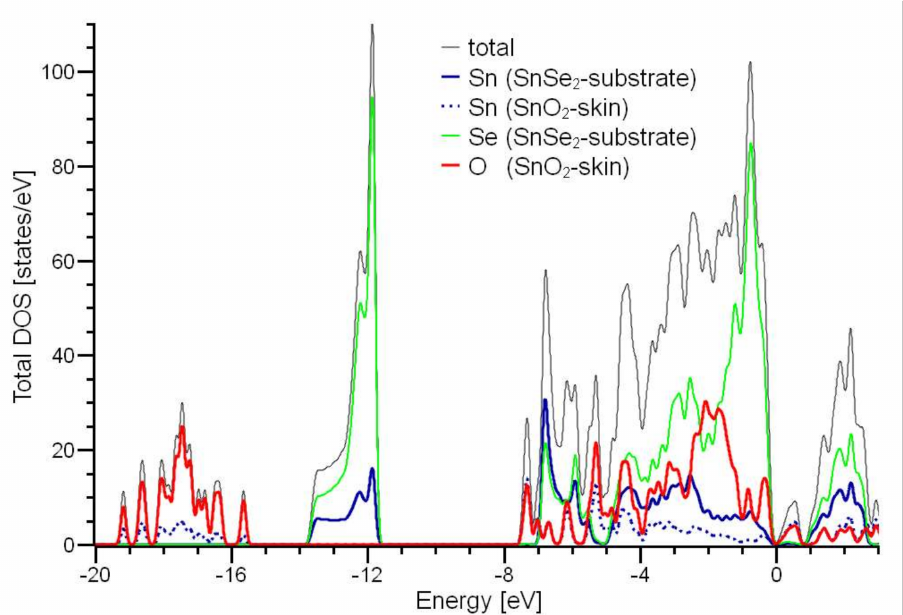
Figure 5. Partial densities of states for SnSe 2 slab with SnO 2 -skin (see Figure 2d). Fermi energy is set as